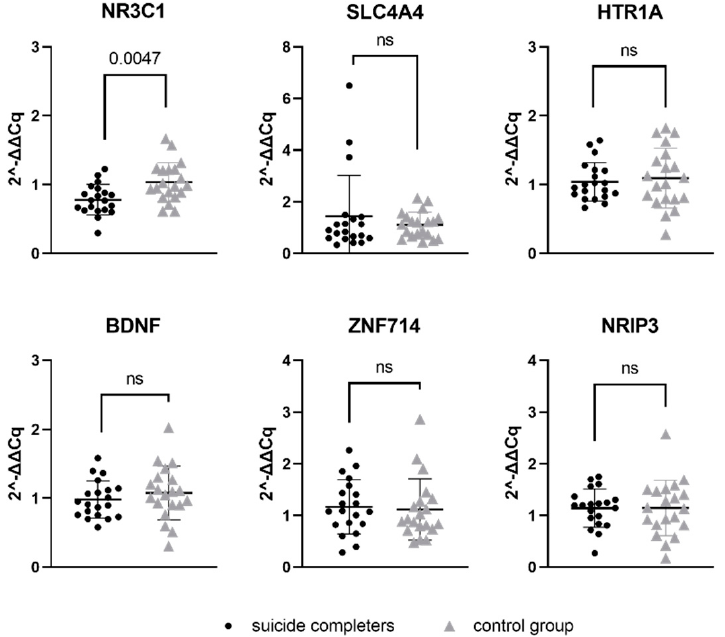
Figure 2. Relative gene expression of target gene mRNAs in Brodmann area 10. Data are presented as a scatter plot, with each point being a measure of relative gene expression per subject for both studied groups. Horizontal lines represent mean value ± standard deviation. Data were analysed using Mann–Whitney U test, with p -values below 0.05 as significant. ns stands for not significant.